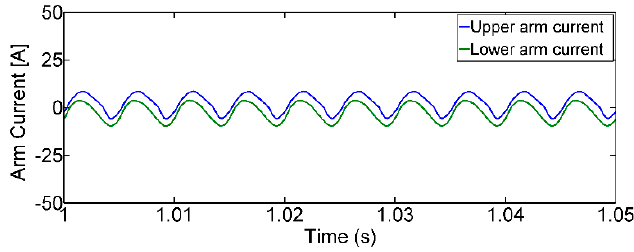
Figure 10. The upper arm and lower arm currents of the proposed DC-DC MMC when r = 0.5.